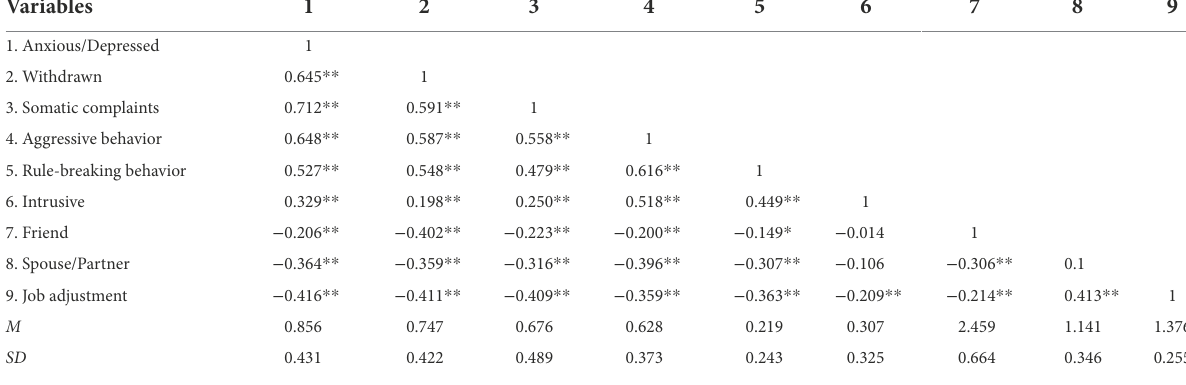
TABLE 1 Inter-correlation matrix with descriptive statistics for research variables.